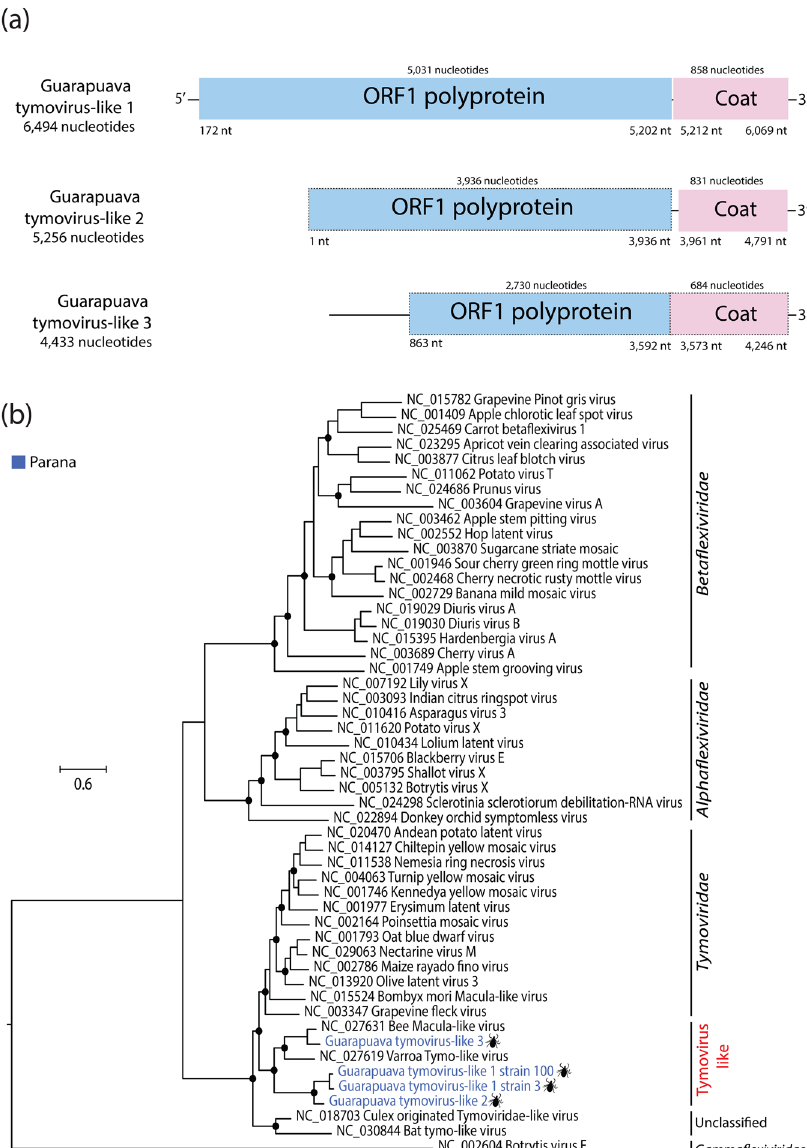
Figure 4. Genome organization of novel tymoviruses ( a ). The ORF1 polyprotein and coat gene are shown in blue and pink, respectively. The respective nucleotides positions of elements in genome are shown at the bottom of figures. Dashed-lines indicate the incomplete gene. ( b ) Maximum likelihood phylogeny of novel tymoviruses into Tymovirales order. Phylogeny was constructed on amino acids alignments sequences with ORF1 polyprotein based on LG + I + G4 amino acids substitution model. Phylogeny was midpoint rooted for clarity of presentation. The scale bar indicates evolutionary distance in numbers of substitutions per amino acids sites. Taxons are colored according to geographical location, and the host was denoted with a silhouette. The legends for the colors are shown on the left. The black circles indicate the main nodes with maximum likelihood bootstrap support levels above 75% bootstrap